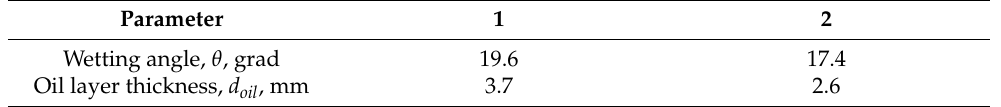
Table 1. Changing the structural characteristics of the oil Shell Gadinia AL 40 for different experi- mental conditions.